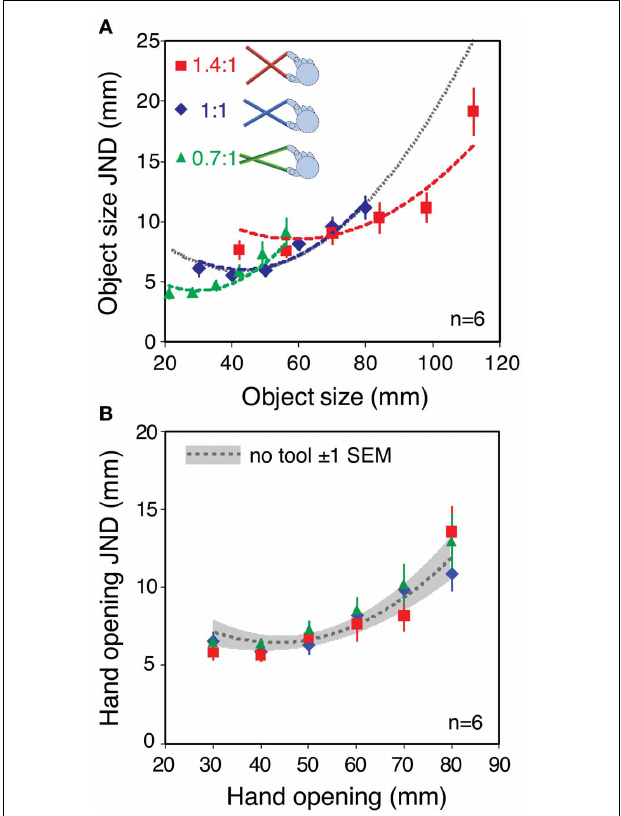
FIGURE 4 | Haptic sensitivity with different tool gains. (A) Object size JNDs as a function of object size, averaged across the six observers. Different colors denote the different tool gains. The gray dashed line shows the fit to the no-tool data in Figure 3 , extrapolated to the whole range of object sizes. This is the predicted sensitivity function is only object size per se determines changes in sensitivity (i.e., a high-level limit). The red, blue, and green dashed lines show the predictions assuming that low-level hand-opening sensitivity limits performance. They were calculated in the same manner as in Figure 1 , by combining the fit to the basic hand-opening sensitivity with the geometrical effects of the tool (see main text). (B) The same data re-plotted in units of hand opening. The dashed gray line again shows the fit to the sensitivity function in the no-tool condition, and the gray zone around it shows ± 1 standard error. Error bars in both plots are standard